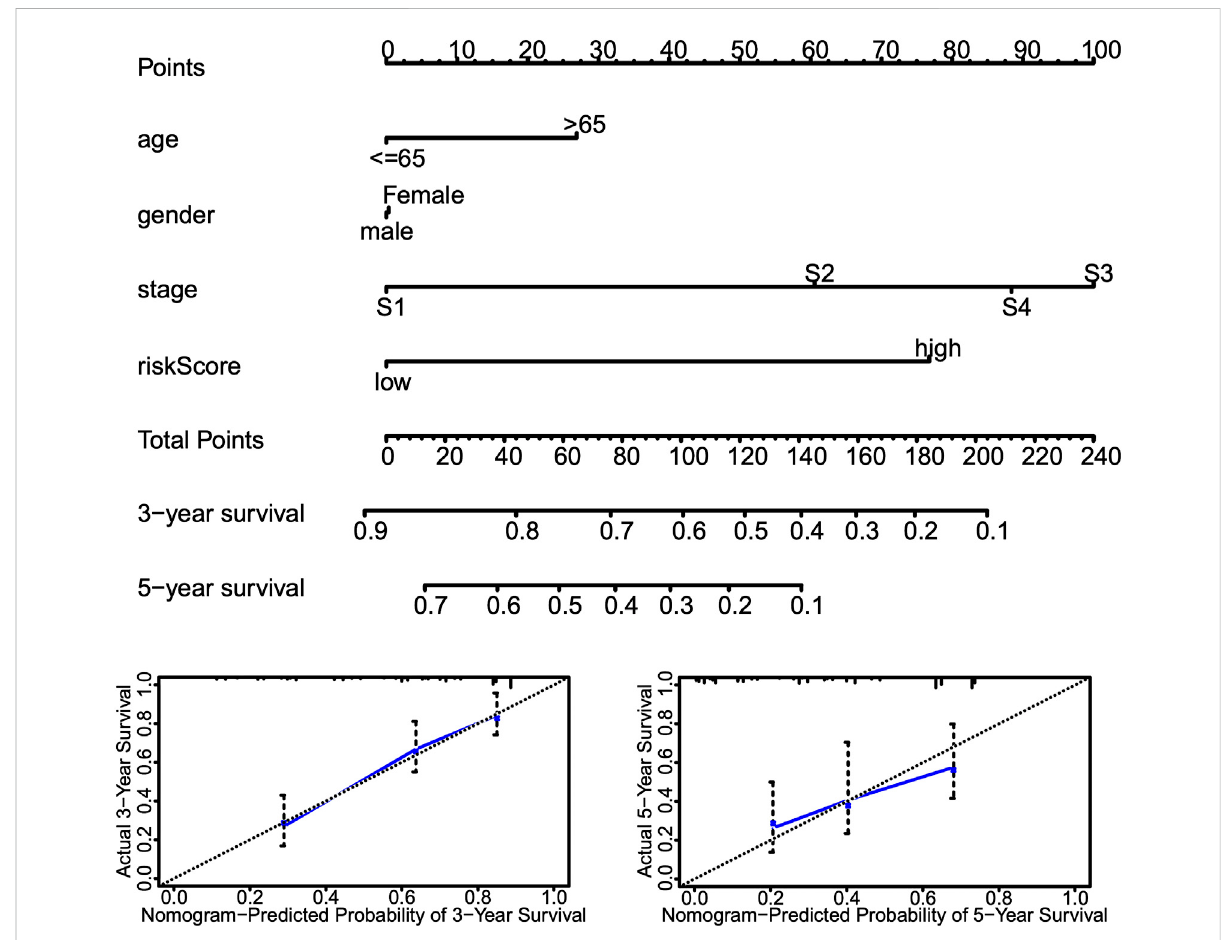
FIGURE 9 Nomogram incorporating risk score and other clinical information. Top, nomograms to predict3- or 5-year OS of patients with LUAD. Bottom, calibration curves of the nomogram for 3- or 5-year OS